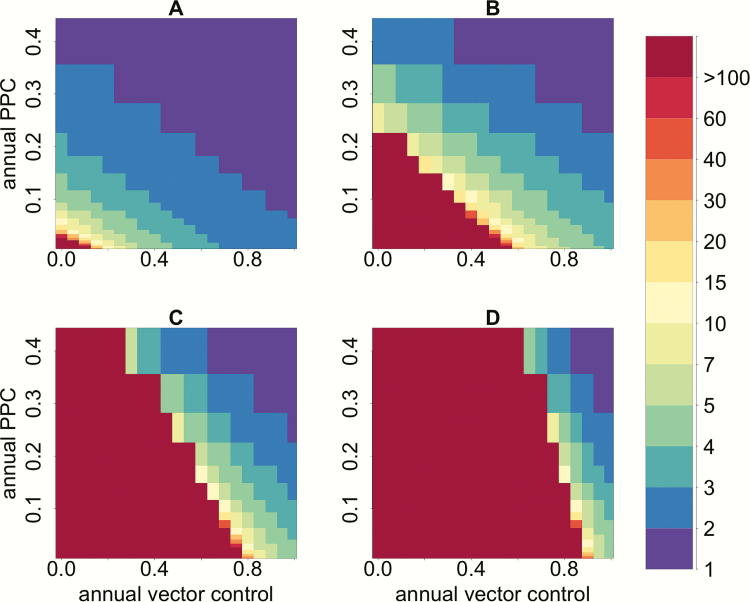
Combined impact of vector control and effective parasite clearance (measured as proportion of parasitological cure [PPC]) on years to reduce seroprevalence in children under 5 to <2%. Annual vector control defines the proportion by which vector density is reduced (0–100%); annual PPC defines the proportion of humans effectively treated, ie, the percentage of the infected human population achieving parasitological cure (0–40%). The color scale corresponds to number of years to achieve the serological criterion. The panels represent: A: low; B: moderate; C: high; D: very high endemicity levels (see Supplementary Materials).